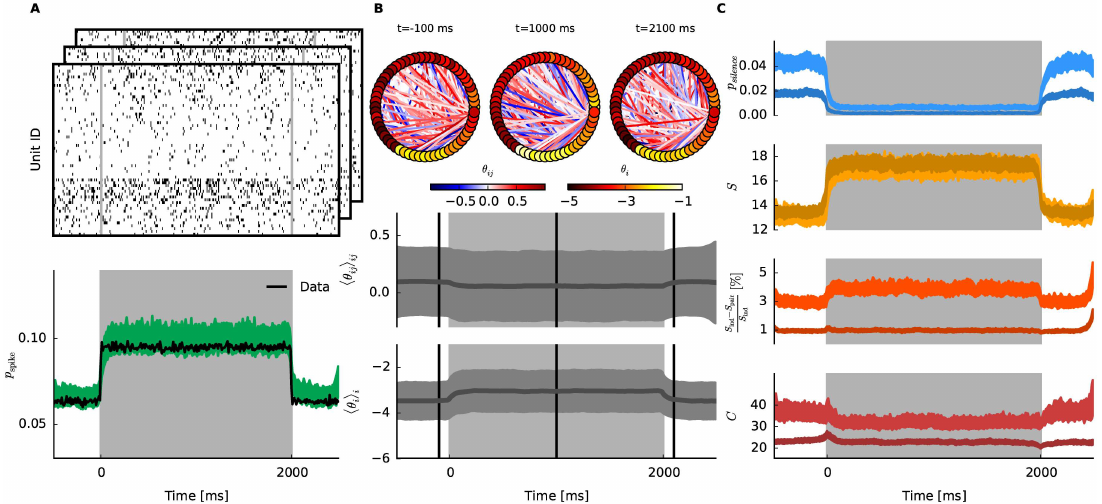
Fig 6. Dynamic network inference from simulated balanced network data. 60 neurons(40 excitatory, 20 inhibitory)are recorded from a simulatedbalanced network of 1000 leaky integrate-and-fire neuronsthat receiveinputs from 800 excitatory orientation selective Poissonneurons(mean firing rate 7.5 Hz when no stimulus present). See main text for the details. Stimulus was presented for 2 s, and 1000 trials are generated.Bin width is 10 ms. The structure of this figure is the same as in Fig